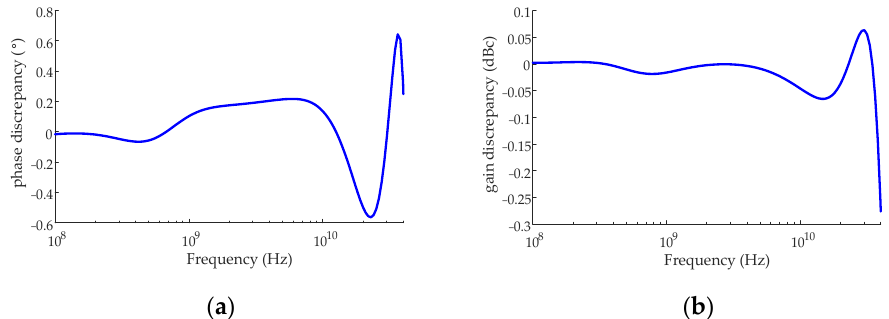
Figure 8. The simulated optical receiver discrepancy. ( a ) phase discrepancy; ( b ) gain discrepancy.